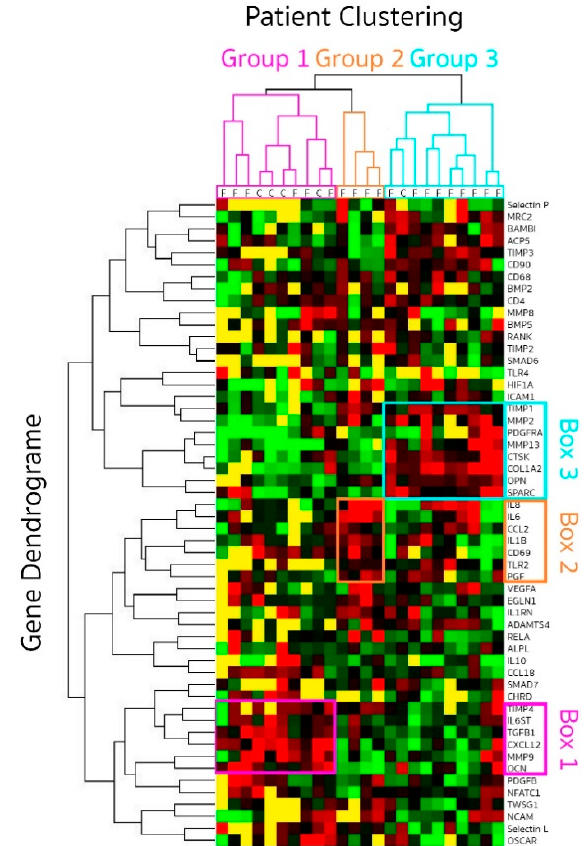
Figure 5. Gene expression profiling displayed as a heat map following hieratical clustering. Genes expression was quantified in bone genes from patients (SG n = 18) at different time points (2 to 14 days) after fracture and healthy controls (HCG n = 6). Clustering grouped patient in three groups (pink, blue and orange) displayed by the patient dendrogram at the top. Genes whose expressions were closely related are illustrated by the gene dendrogram on the left. Level of expression for each gene is coded red when high and green when low. Below detection levels are coded in yellow .